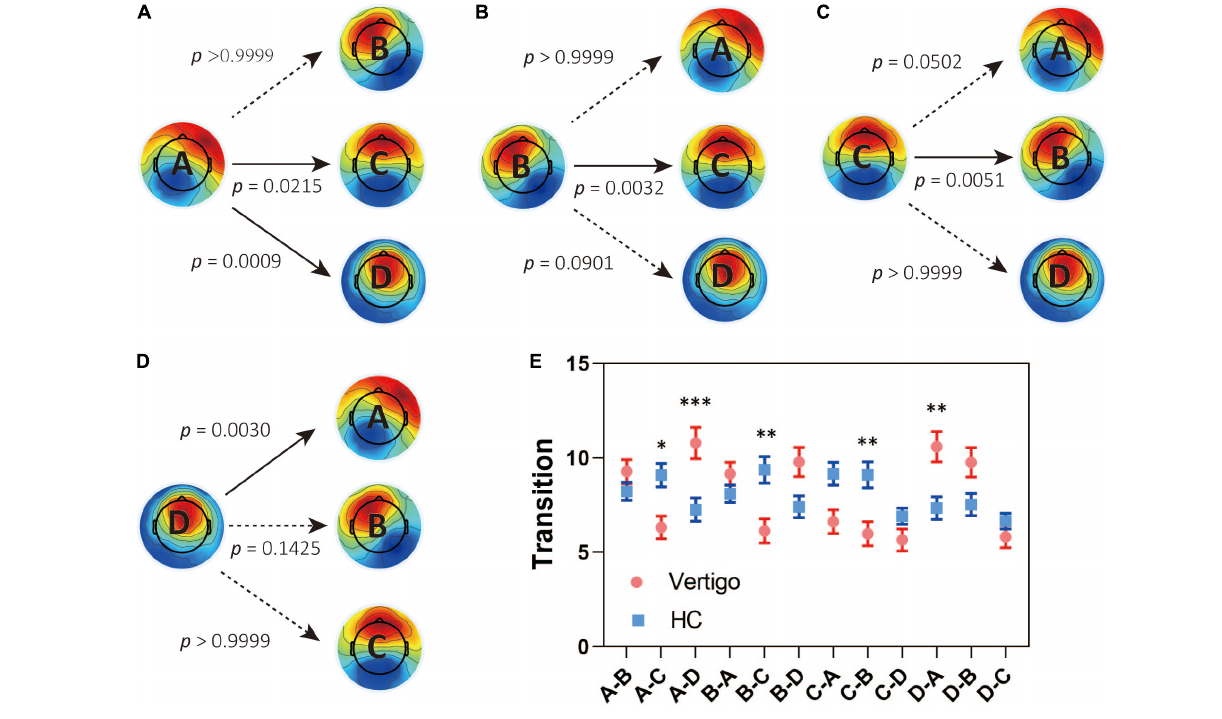
FIGURE 2 | Results for the syntax analysis between patients with vertigo and healthy controls. Transitions from (A) Class A, (B) Class B, (C) Class C, (D) Class D to the other three classes. (E) The transitions in both groups and the between-group difference in syntax analysis. Data of patients with vertigo are displayed in red and controls in blue. Solid arrows indicate significant differences. ∗ p < 0.05, ∗∗ p < 0.01, ∗∗∗ p < 0.001 by post hoc pairwise comparisons with Bonferroni’s correction for 12